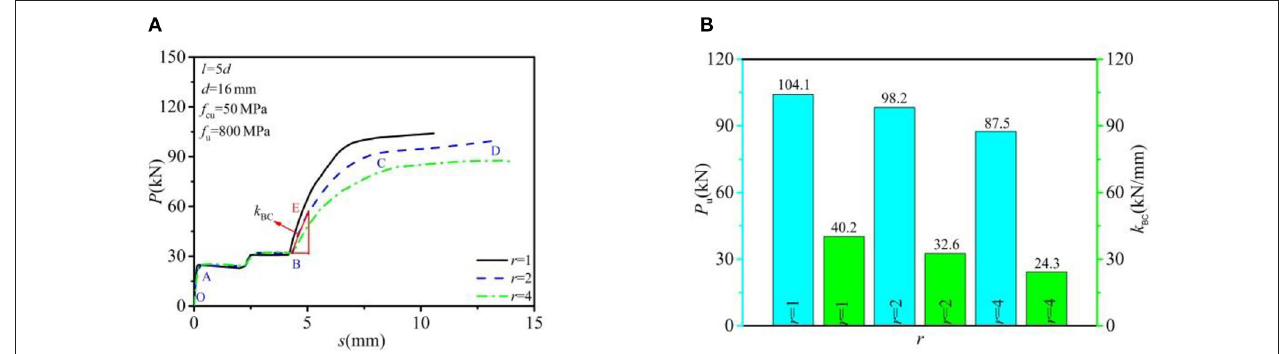
FIGURE 5 | Analyzed results per bolt connectors in MBSCs: (A) load–slip relationship and (B) shear capacity and shear